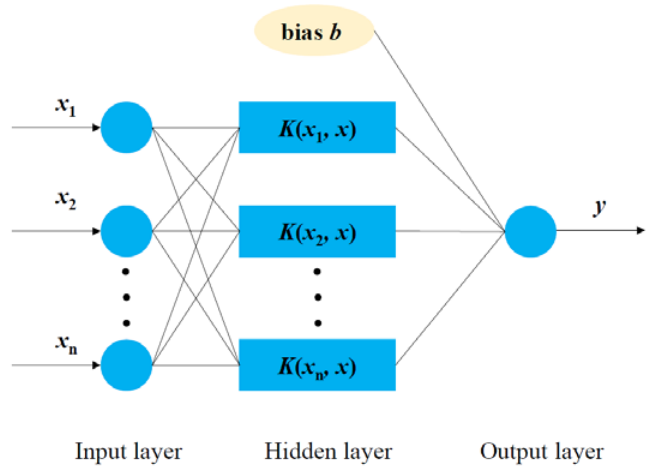
Figure 2. The flow chart of this research.